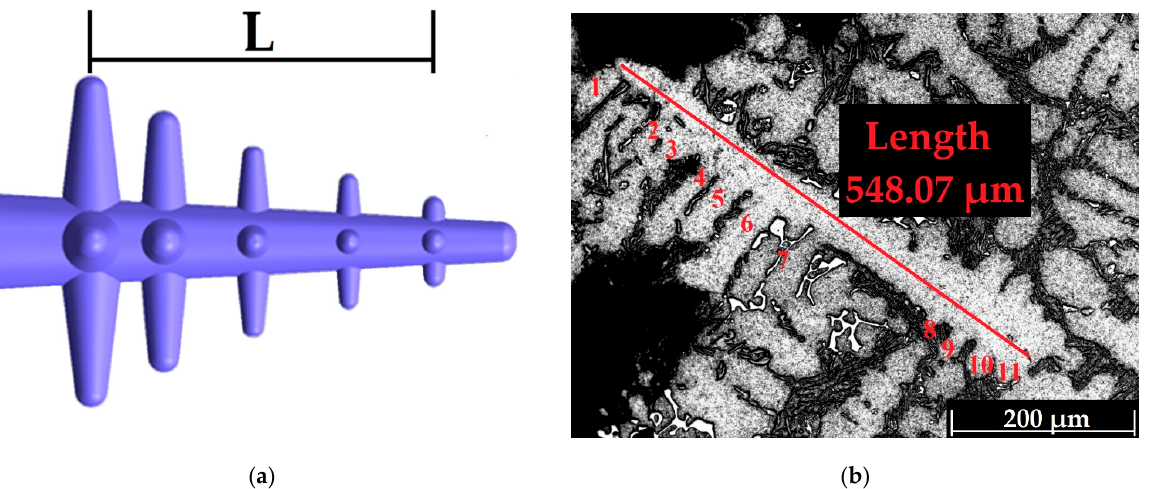
Figure 4. SDAS determination shows ( a ) the dendrite scheme for the SDAS measurement, and ( b ) the length measurement of a dendrite and the number of secondary arms.